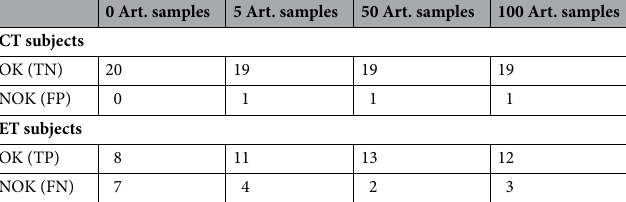
Table 3. Detailed results of the number of subjects correctly and incorrectly classified for each class, depending on the number of artificial samples